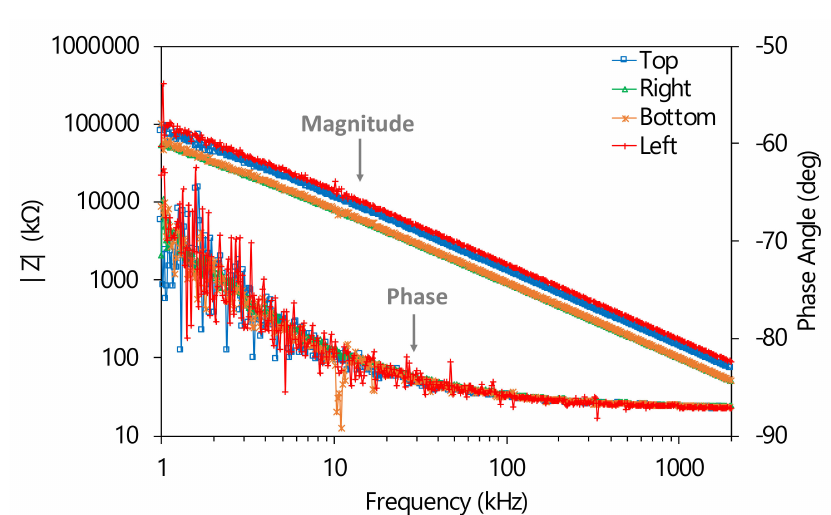
Figure 12. Multilayer smart-3D-device.